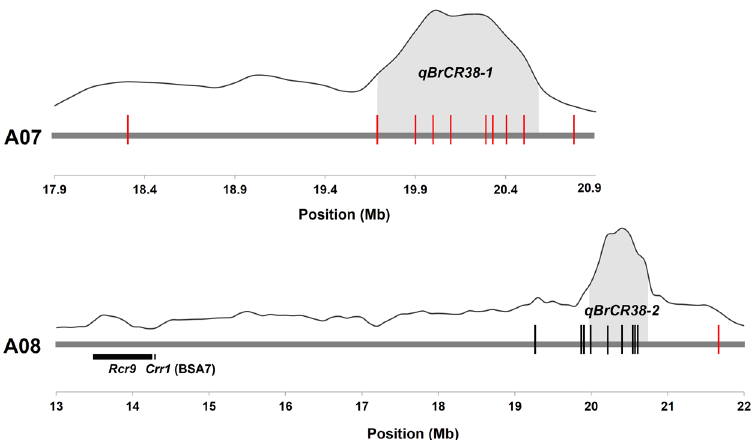
Figure 3. Close-up view of qBrCR38-1 and qBrCR38-2 and KASP markers link to the target regions of CR. Vertical lines represent the position of KASP markers, where red lines were significant (P < 0.05) associated with CR. Gray areas is the target regions.